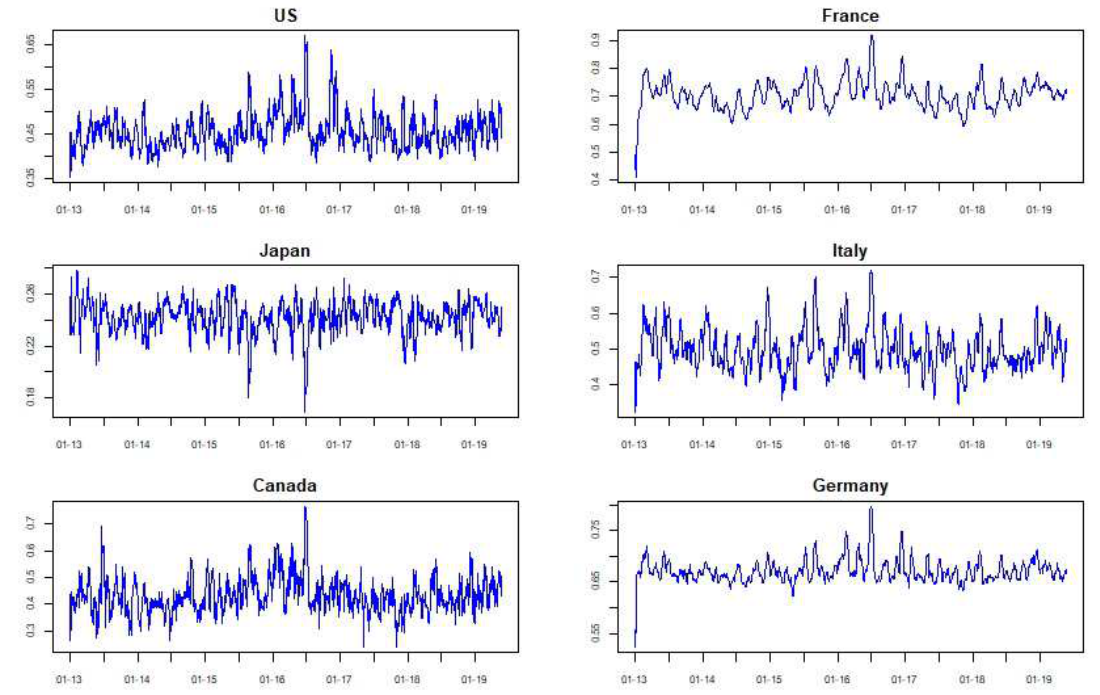
Figure 1. Time-varying dependence of best copula fits between G7 and UK bank equity